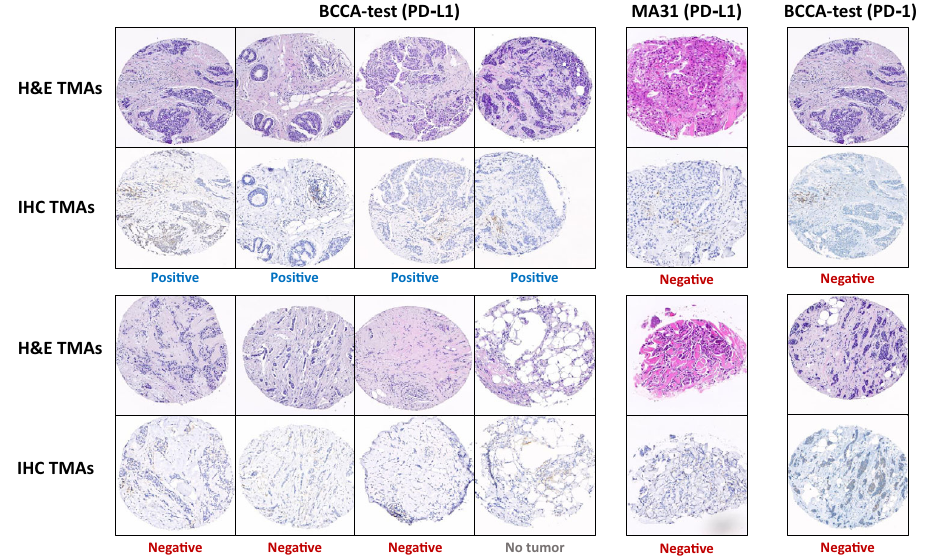
Fig. 4 | Low-prediction score cases classi fi ed positive. Tissue images of patients classi fi ed positive bythe fi rst pathologistand low-PS by the system. The BCCA-test patientsareshownontheleft(byPD-L1)andright(byPD-1),andtheMA31patients are shown in the middle (by PD-L1). For each patient, a representative H&E image